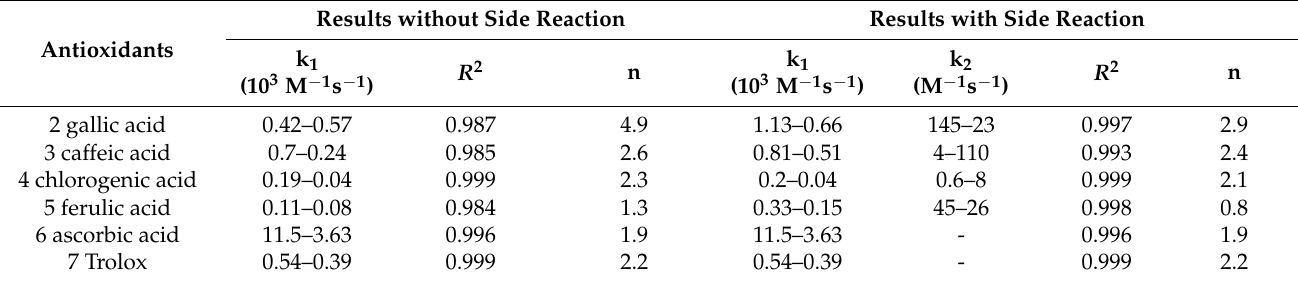
Table 2. Observed rate constants, k 1 and k 2 (M − 1 s − 1 ), R 2 values and stoichiometric factors, n, for the reaction of DPPH • 100 µ M with antioxidants (2–7) 10 and 100 µ M at 25 ◦ C in methanol, without and with side reaction. The values obtained are the mean of at least three repetitions, with a standard deviation of max